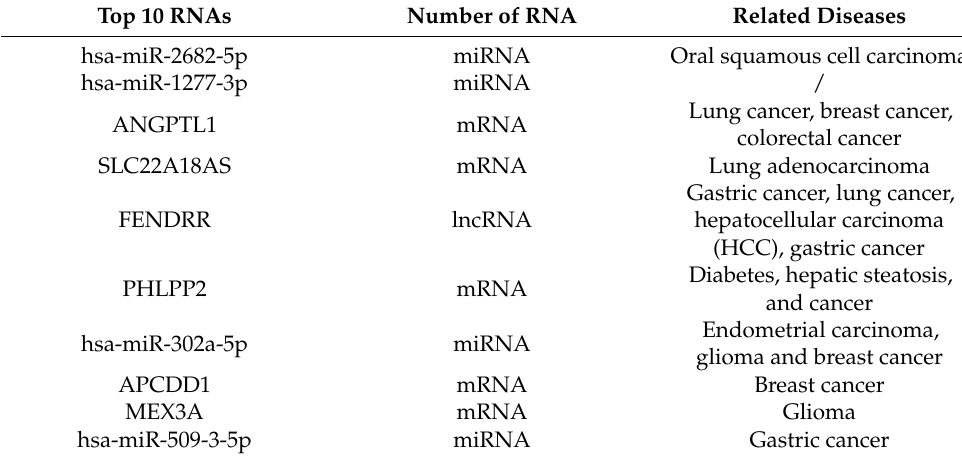
Table 5. Top 10 RNAs and Related Diseases. Top 10